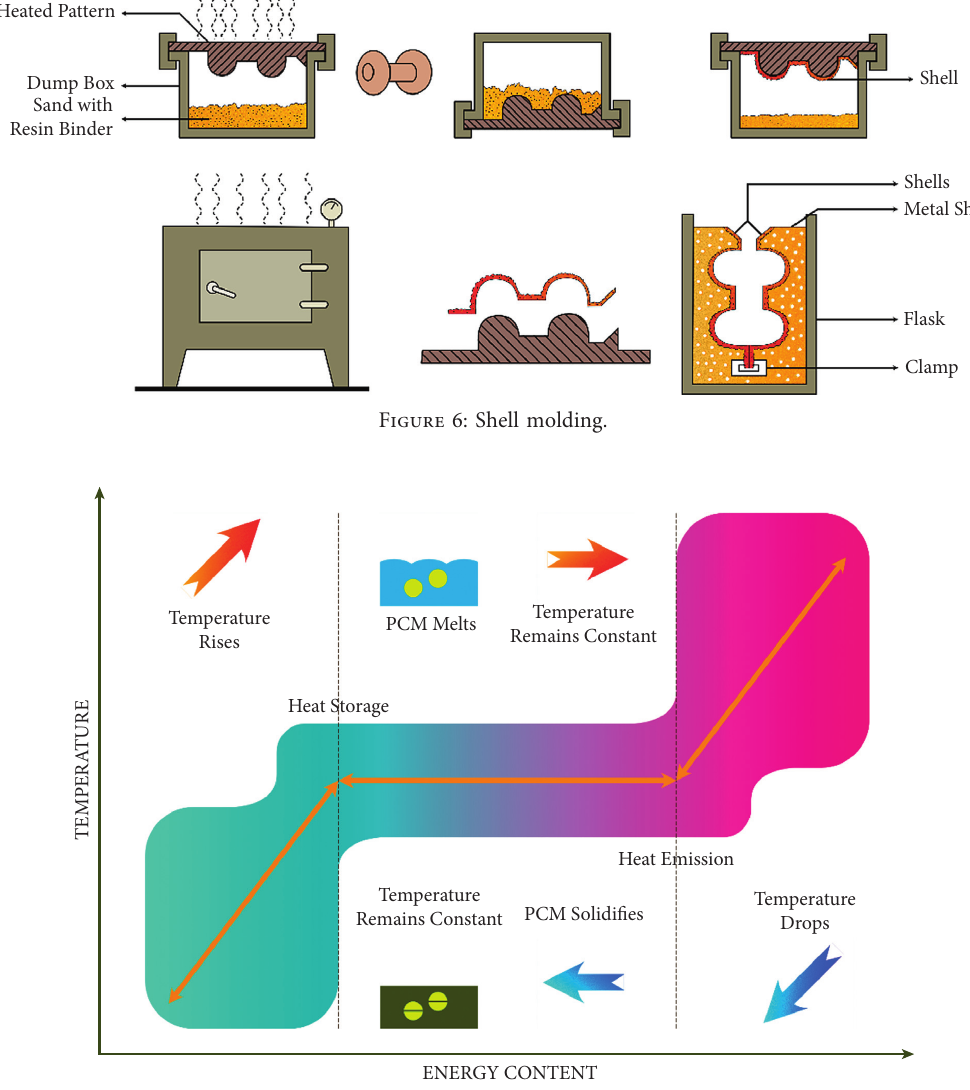
Figure 7: Principle of PCM: graph between temperature and energy content for PCM.